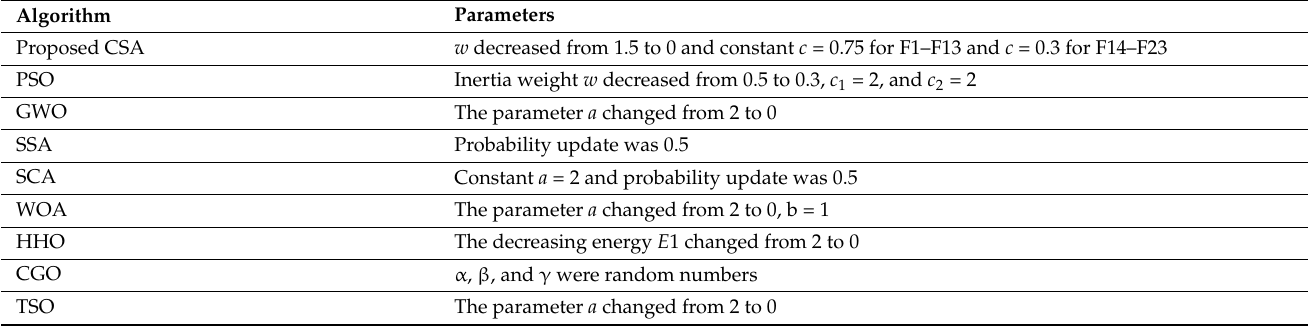
Table 5. Parameters of the applied